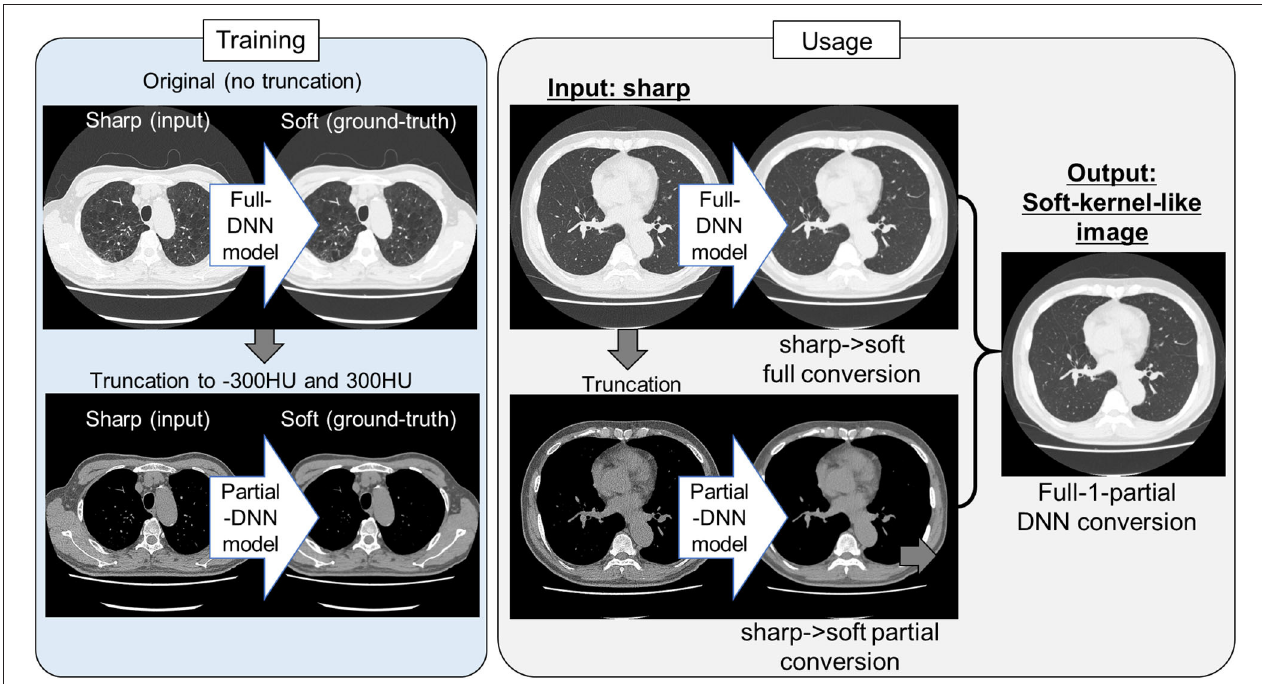
FIGURE 3 | Protocol for the present sharp to soft kernel image conversions using full and partial deep neural networks. In training deep neural network (DNN), pairs of original sharp kernel and soft kernel images were used as input and ground-truth, respectively. One model fully used these pairs without truncation (Full DNN model). The other model partially used these pairs by truncating CT values to − 300 and 300 HU (Partial DNN model). By using the full-DNN model and partial-DNN model, sharp-kernel images in an independent validation dataset, were converted to soft-kernel-like images, respectively. Then converted two images were merged to finalize soft-kernel-like images (Full-1-parital DNN